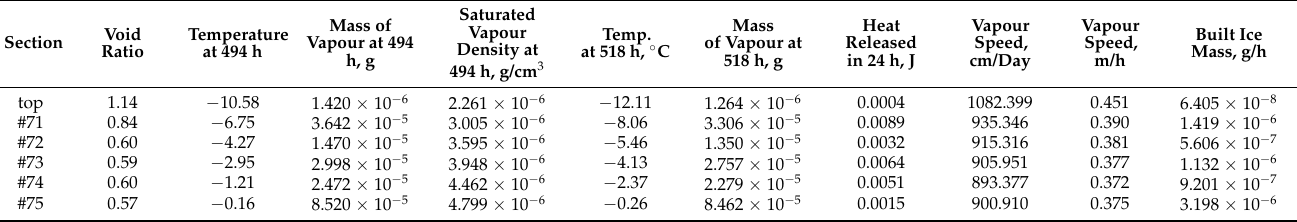
Table A1. Calculation of soil parameters for the 24 h time interval for column